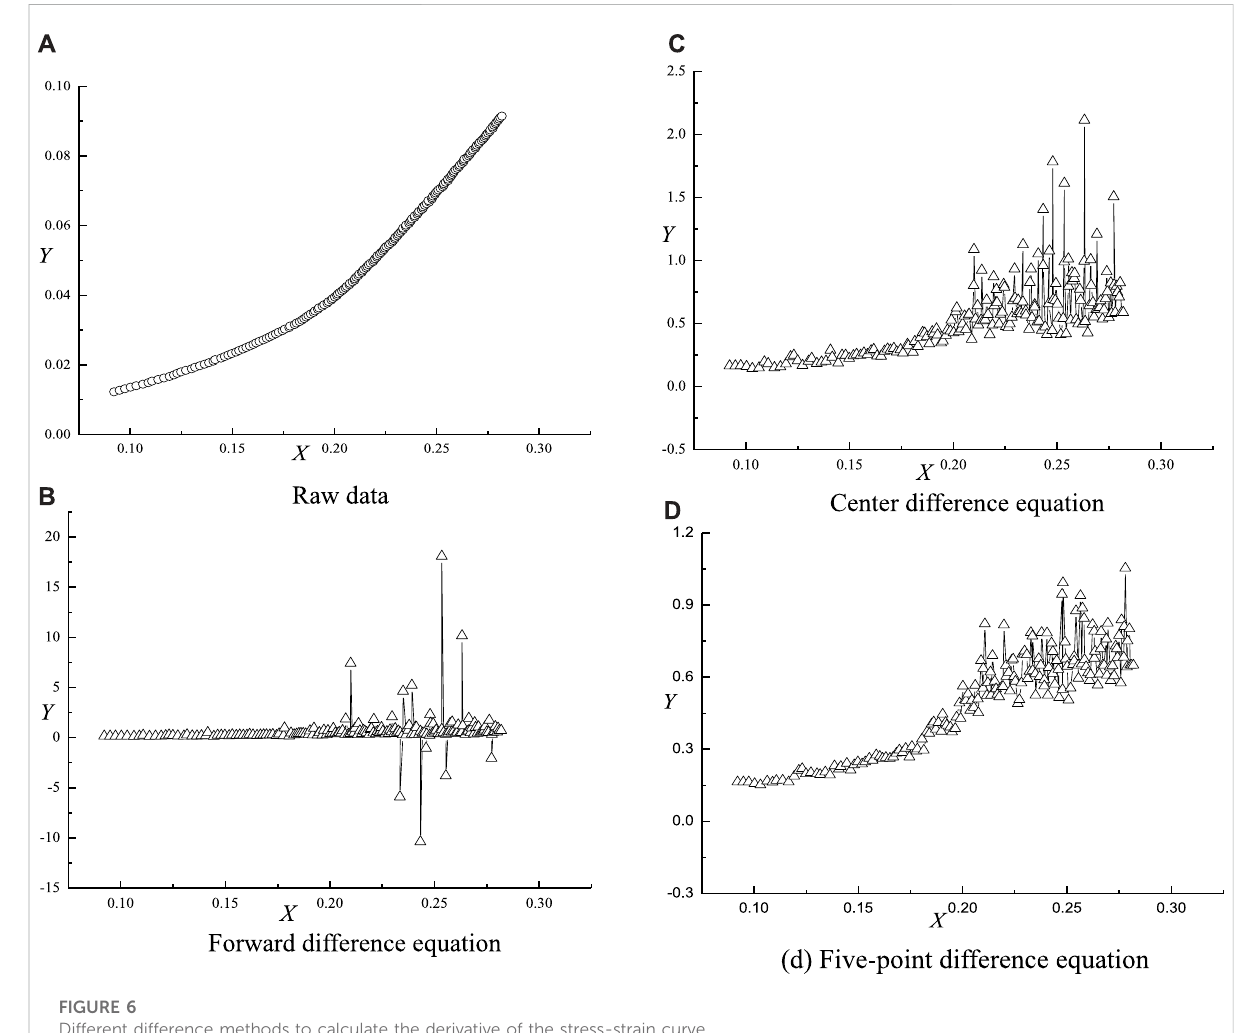
FIGURE 6 Different difference methods to calculate the derivative of the stress-strain